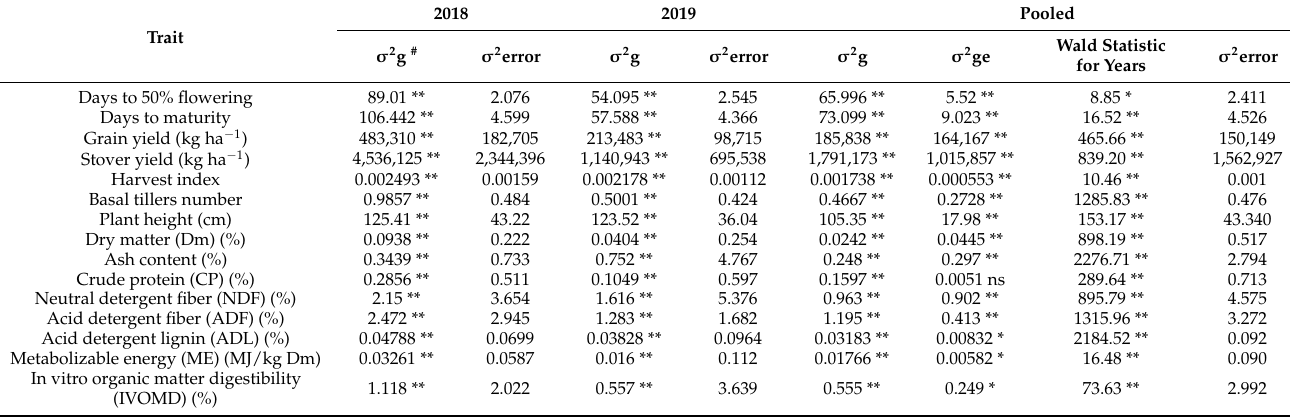
Table 1. Estimated variance components for agronomic and forage quality traits of finger millet accessions evaluated in 2018 and 2019 at ICRISAT, Patancheru, India. Trait Days to 50%